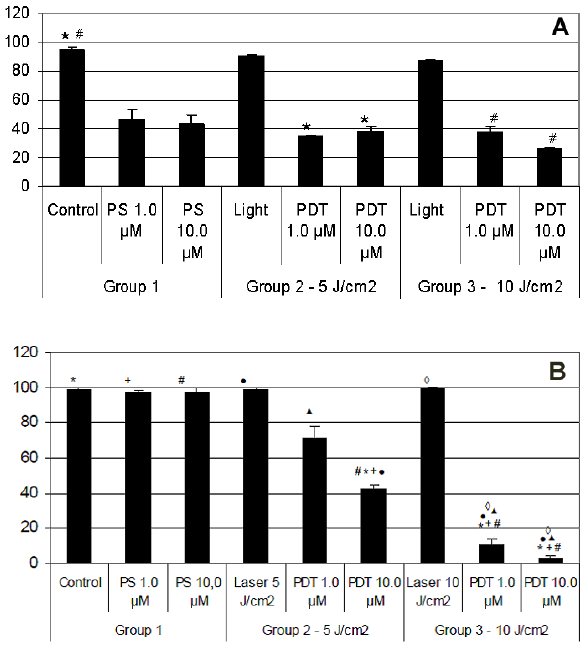
Figure 1. Promastigote viability analyzed by the trypan blue dye exclusion method after photodynamic therapy with AlPcS . ( A ) Leishmania 4 major , ( B ) Leishmania braziliensis. The same symbols represent statistical differences between groups at a significance level of p > 0.05 to Leishmania major and p > 0.01 to Leishmania